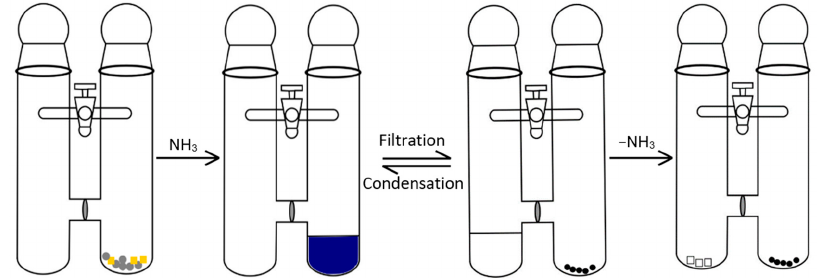
Figure 1. Schematic drawing of the experimental process. Yellow squares represent thallium(I) salts, gray circles represent sodium, white squares represent sodium(I) salts, and black circles represent NaTl. Once the solution had turned colorless, the ammonia was poured through the frit into the second leg and condensed back onto the reactants, this procedure was repeated three